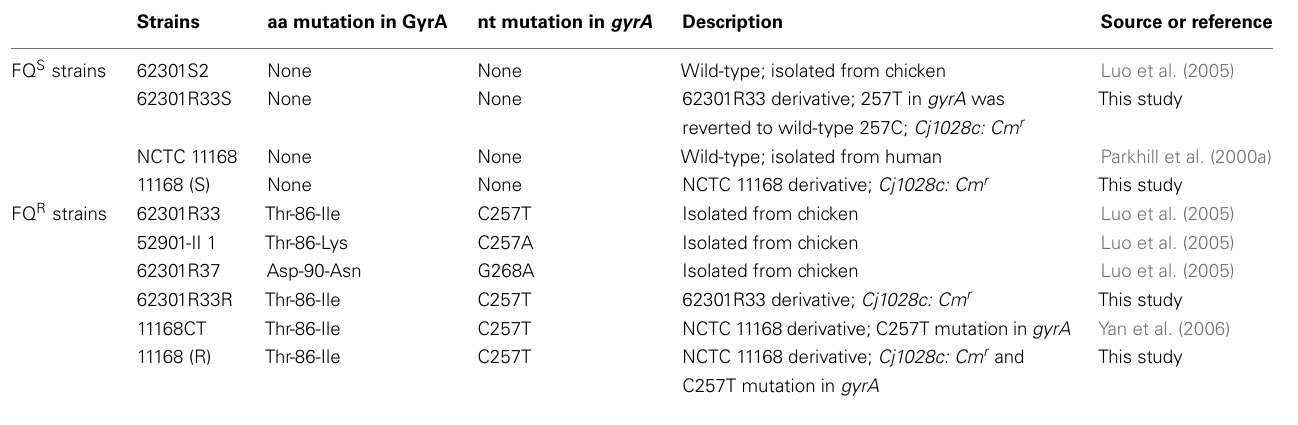
Table 1 | Bacterial strains used in this